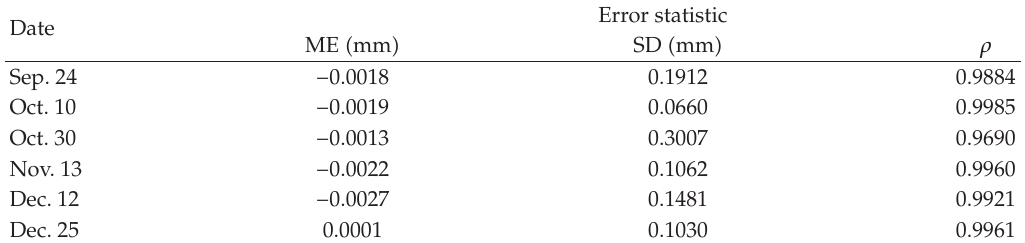
Table 1: Some error statistics from gauge predictions of all sampling points in Jiulong-Beijing track section from K612 (cid:8) 000 to K614 (cid:8)